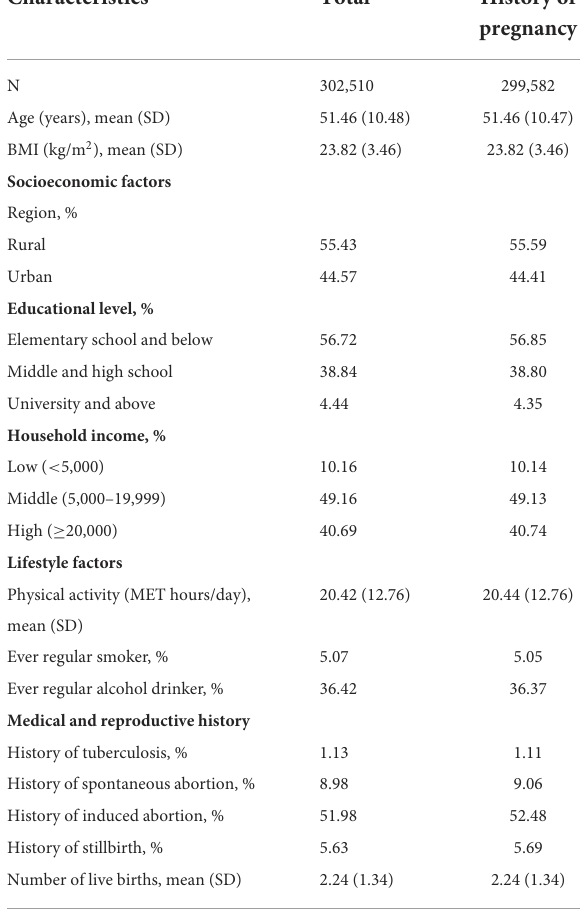
TABLE 1 Baseline characteristics of study